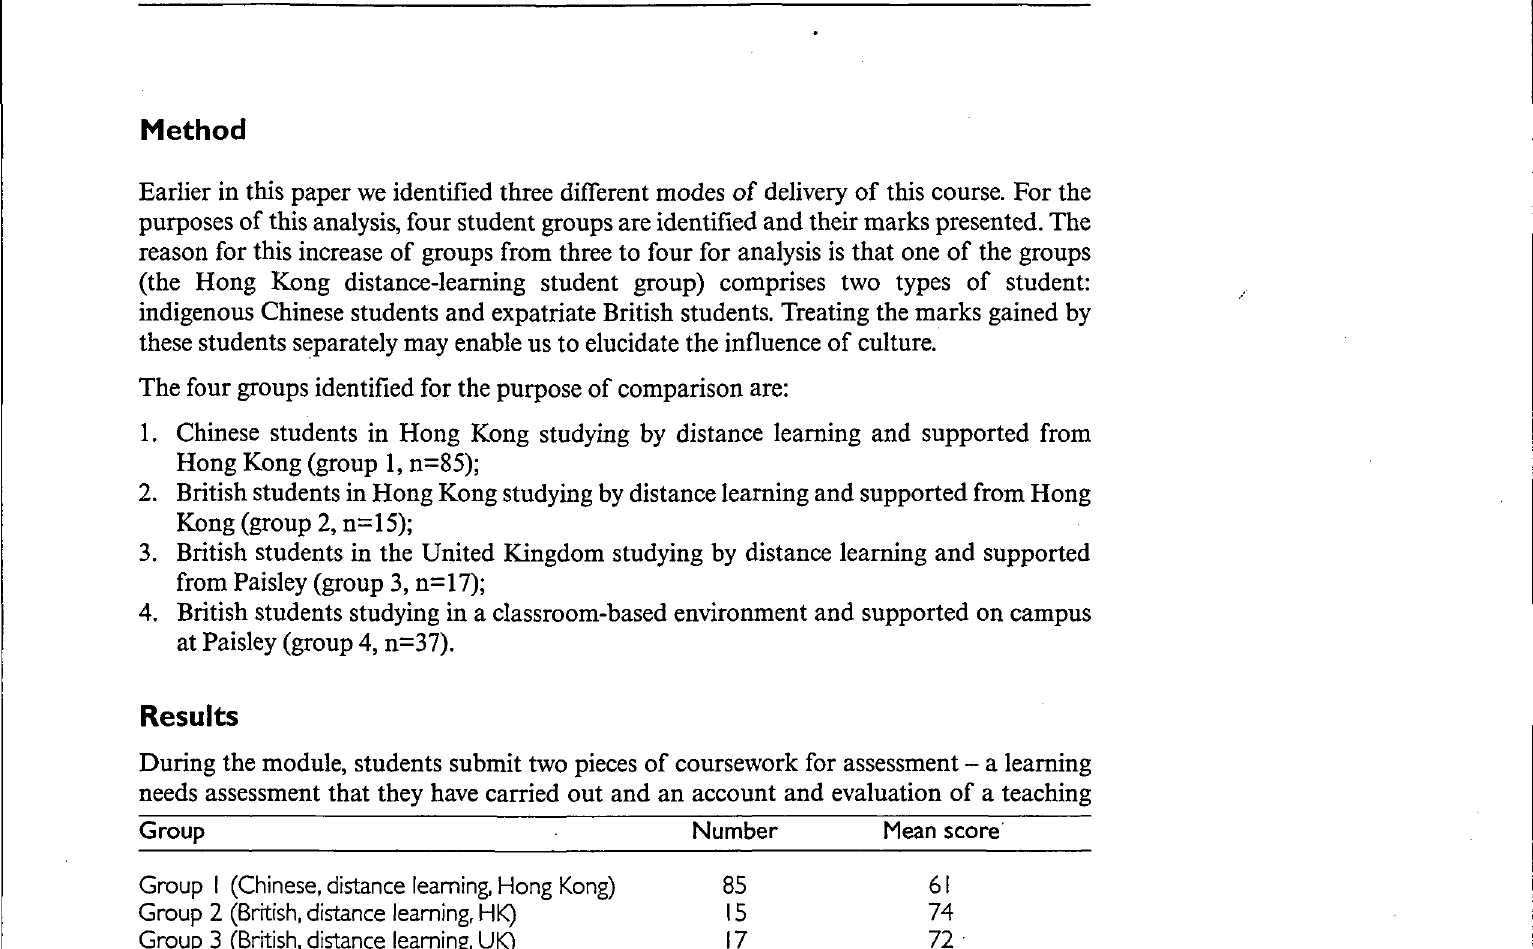
Table 2: Assessment results for the four groups of students: mean scores for the module 'Professional Practice